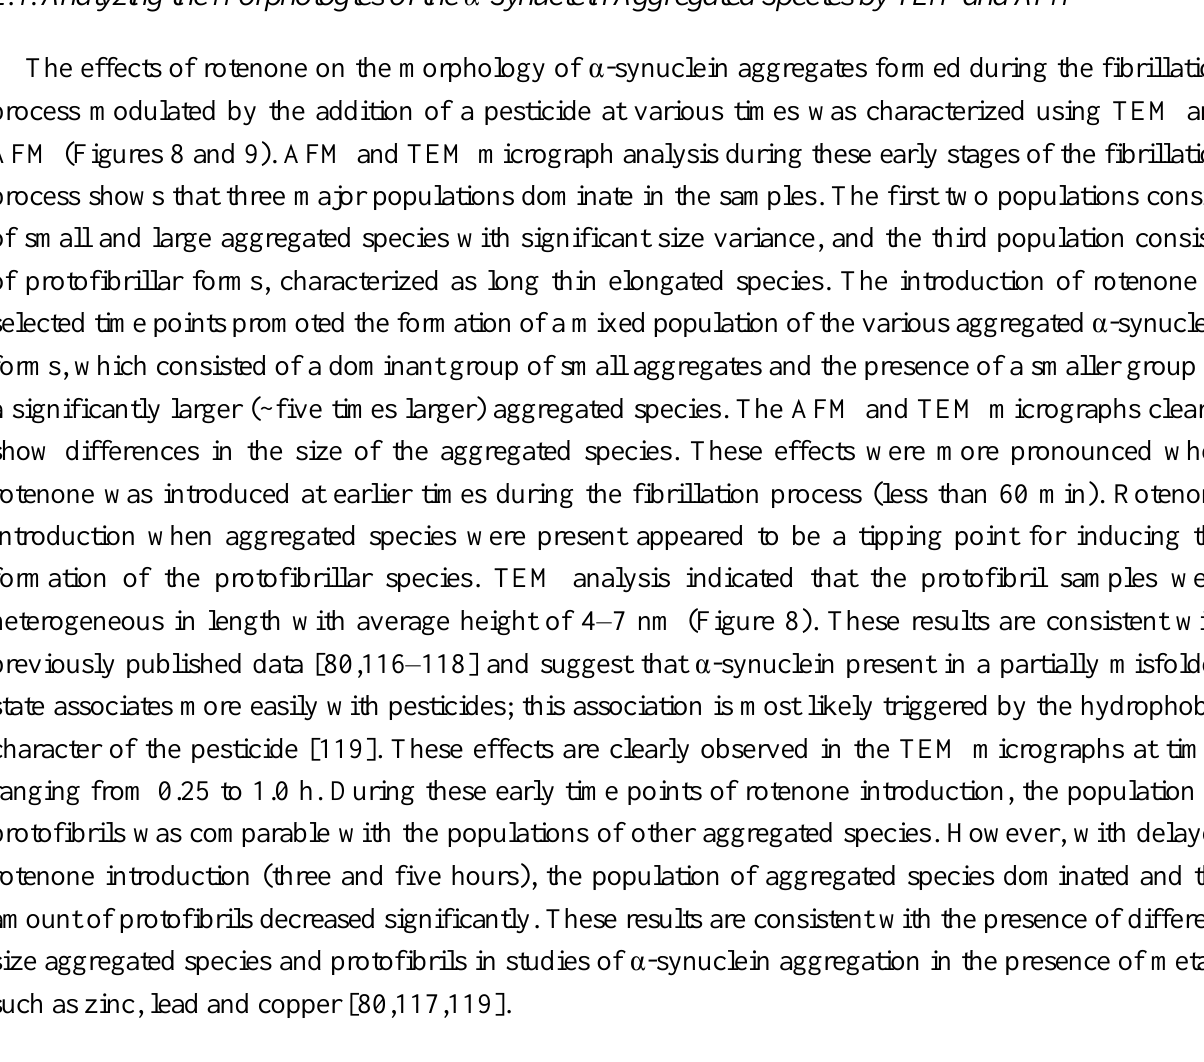
Figure 9. Multiple TEM micrographs, samples obtained at time of rotenone addition: 0 h; 15 min; 30 min; 1 h; 3 h; 5 h.